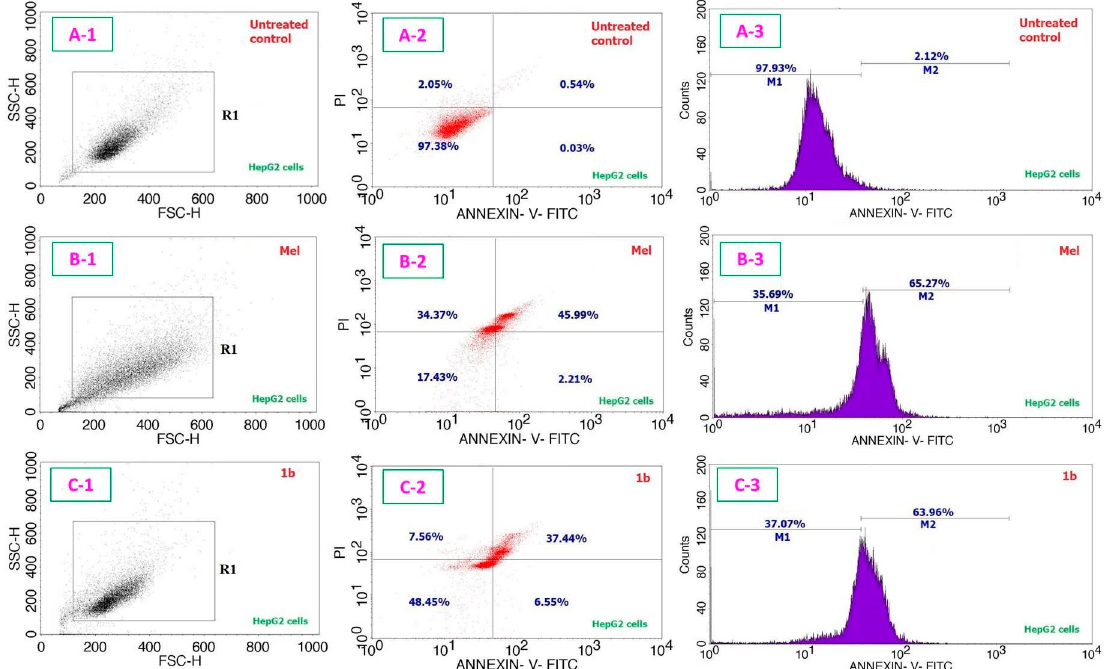
Figure 5. Comparison of apoptosis assay results for HepG2 cancer cells at 48 h incubation period. From the figure, A, B, and C correspond to the negative control, the positive control (Mel; 15 μ g/mL), and compound 1b, respectively, while 1, 2, and 3 stand for the population of cells selected for the analysis (FSC-H: forward scatter histogram; SSC-H: side scatter histogram), combined fluorescence from PI and Annexin-V-FITC, and pure Annexin-V-FITC fluorescence, respectively.